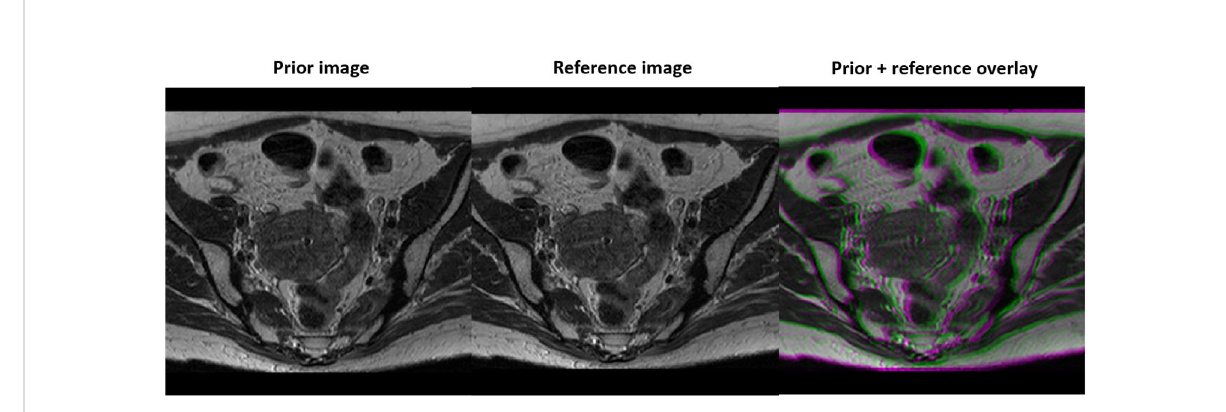
FIGURE 2 Prior MR image (left), MR image with simulated motion (middle), and the overlay of the two illustrating deformation between the two